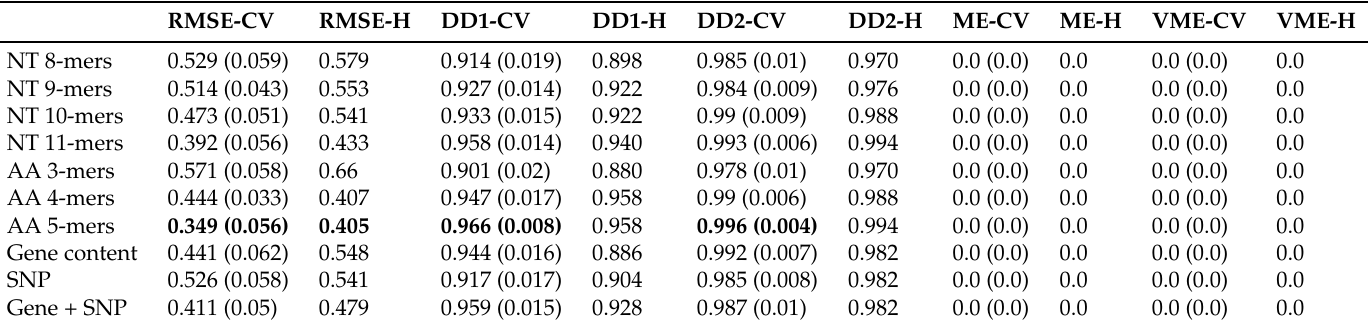
Table A47. K. pneumoniae –ciprofloxacin.